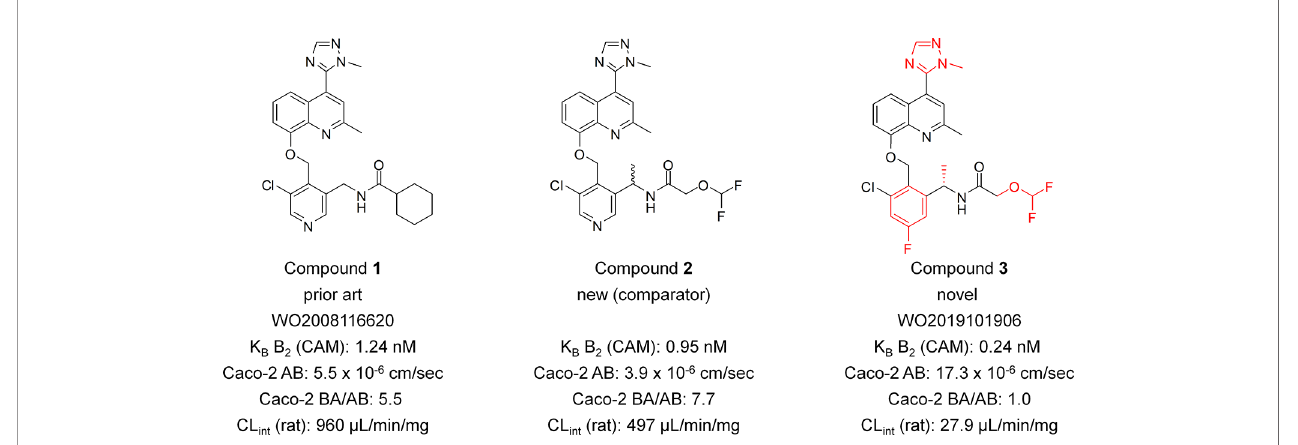
FIGURE 1 | Structures of Compound 1, Compound 2, and Compound 3 and their selected key properties. Key structural elements of the novel series indicated in red. Caco-2 AB, permeation rate apical to basolateral direction. Caco-2 BA/AB, ratio of permeation rates basolateral to apical direction and apical to basolateral